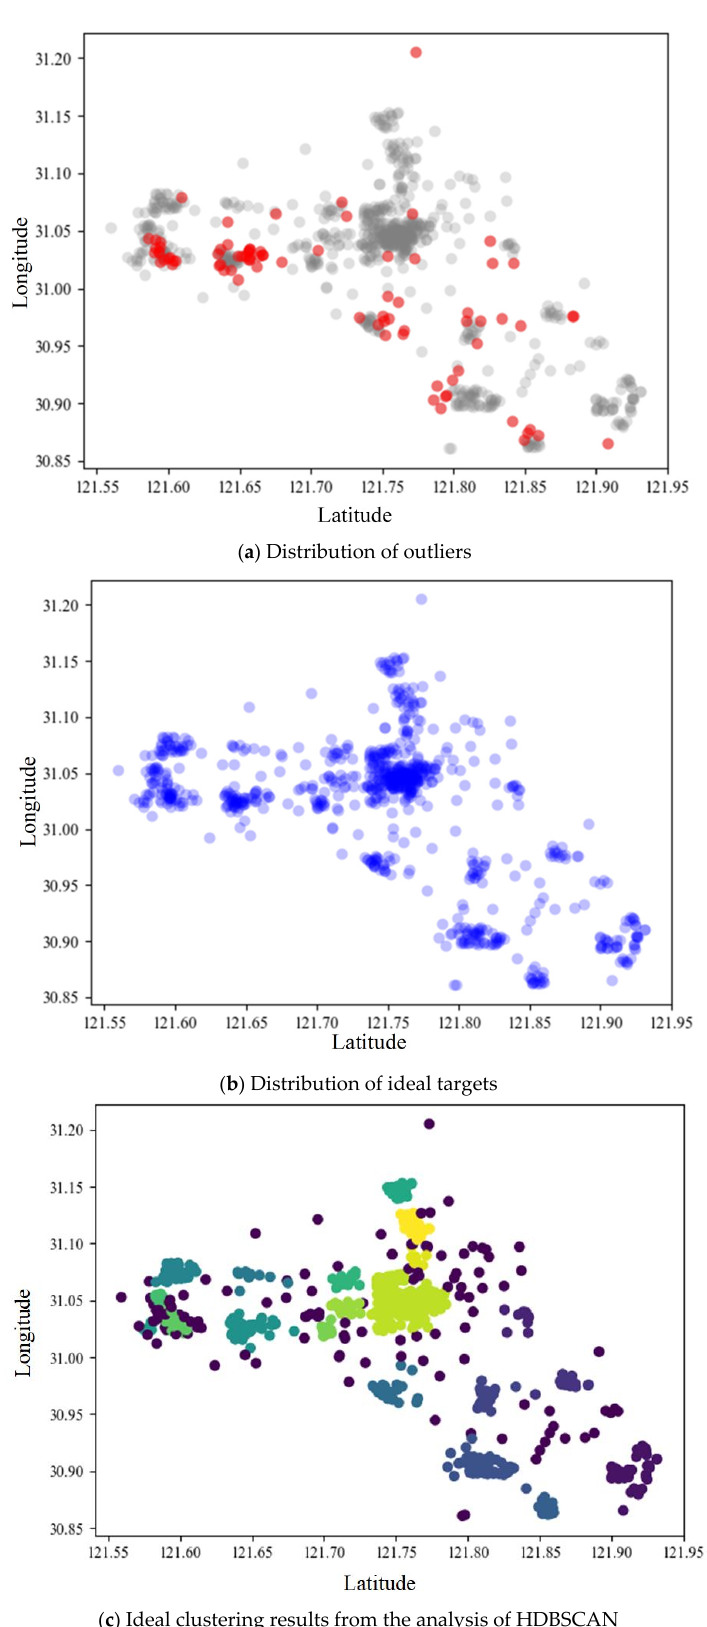
Figure 13. Result of GLOSH detection: ( a ) The data points of the red label are outliers; ( b ) The data points of the navy blue label are ideal targets; ( c ) The data points marked with non-purple color as the ideal clusters.